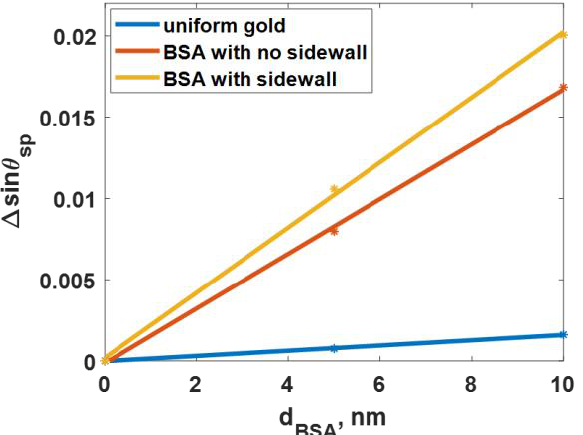
Figure 13. The Δ sin θ sp for different deposited thicknesses of BSA from 0 nm (bare gold) to 10 nm for ideal smooth gold surface, rough gold surface with h of 9 nm, and cl of 8 nm for the no sidewall and sidewall coating cases.